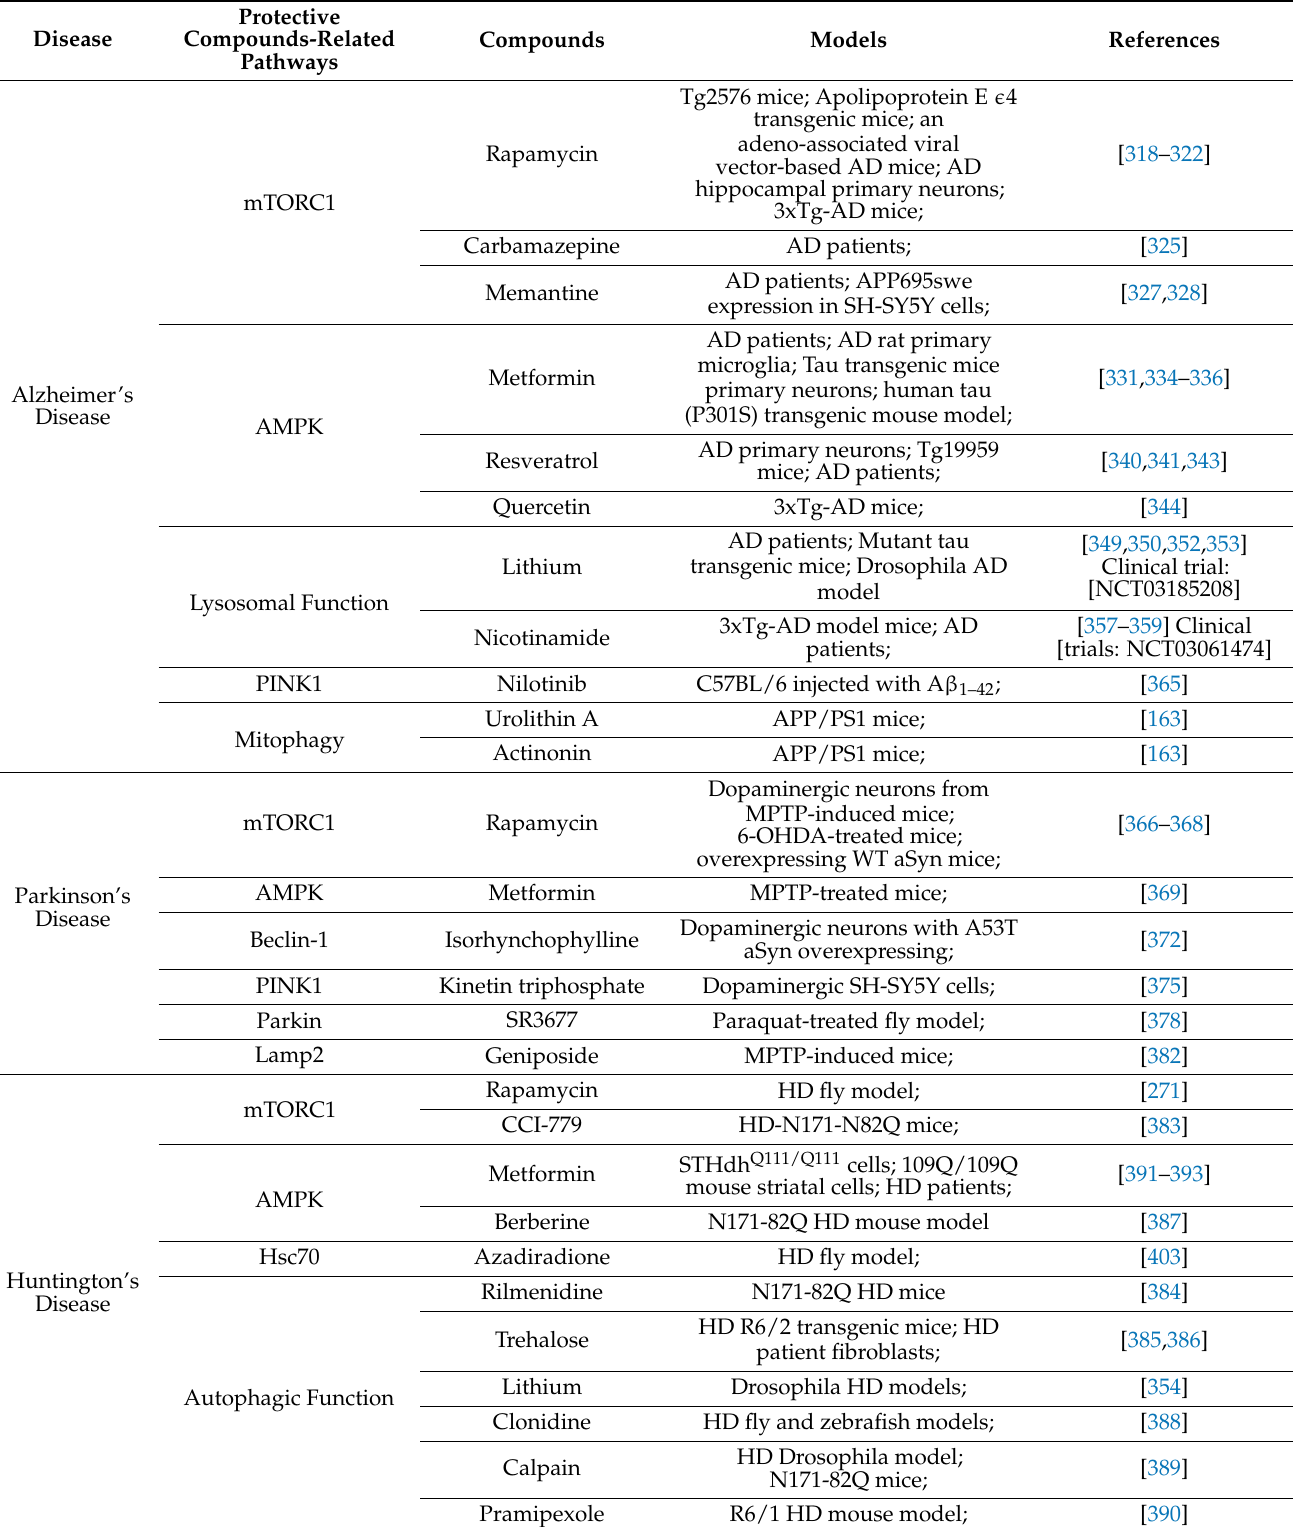
Table 1. Compounds-related pathway’s inhibitors or activators shown to exert beneficial effects in AD, PD, and HD models.